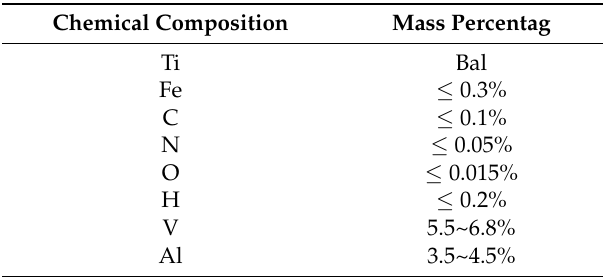
Table 2. Content of elements in TC4 titanium alloy.